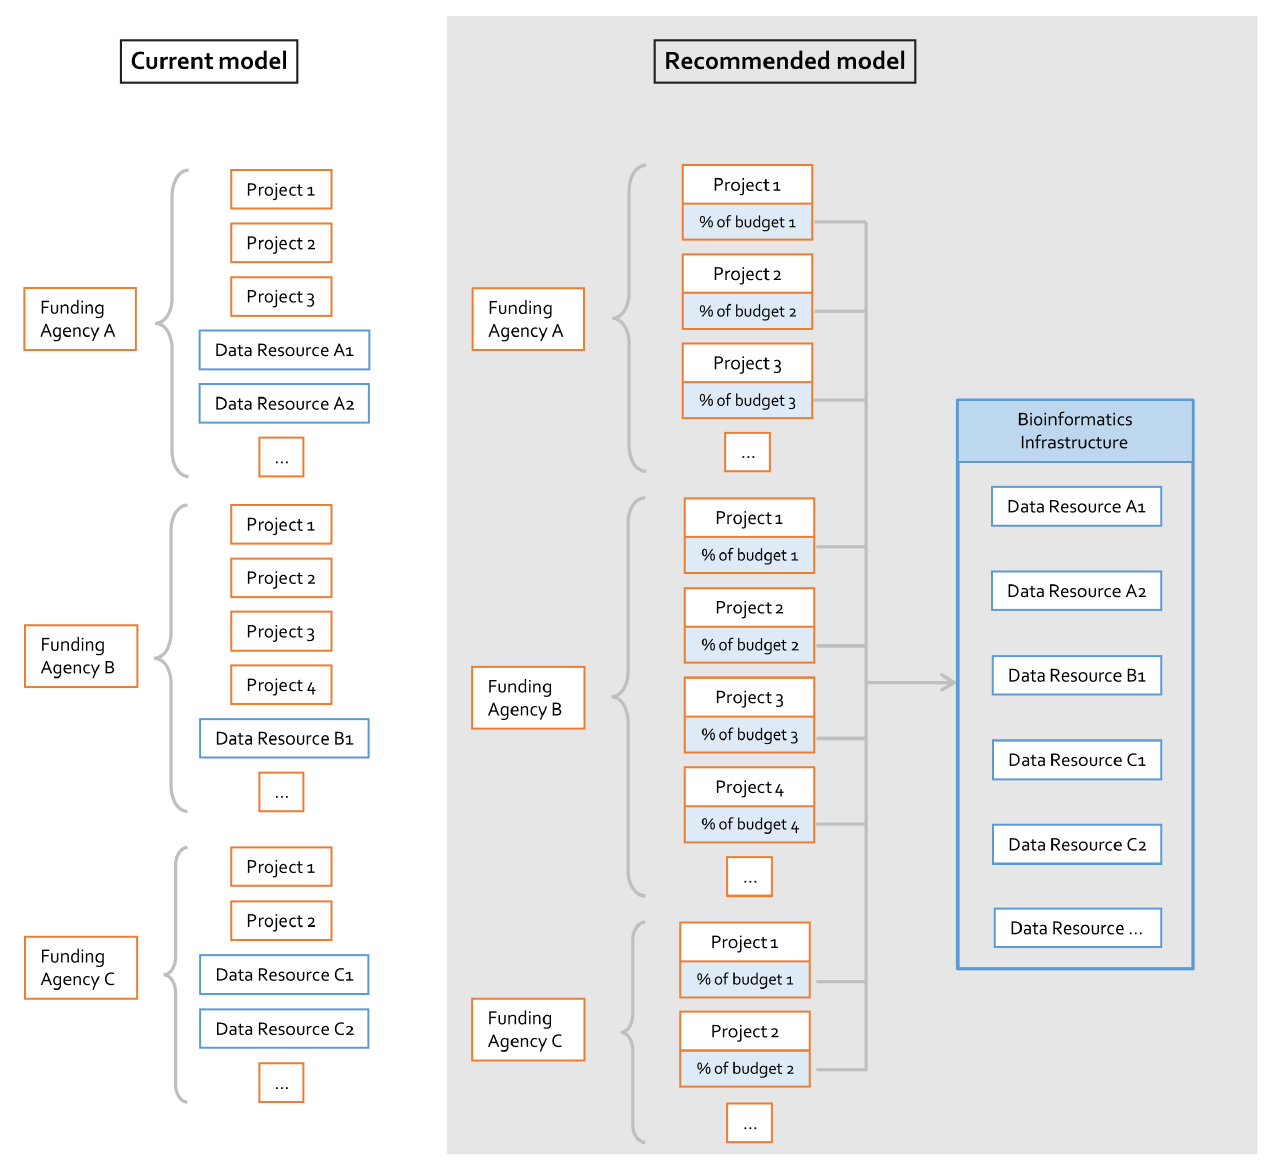
Figure 2. The Infrastructure Model on the level of the funding agency. On the left, the current model, in which databases compete cyclically for grants against research or resource projects. On the right the Infrastructure Model, in which the funding agencies distribute research grants only to research projects. A percentage of each grant is retained and assigned to a budget for data stewardship, and subsequently redistributed among the relevant infrastructures, including Data Management Plans providers, deposition databases and